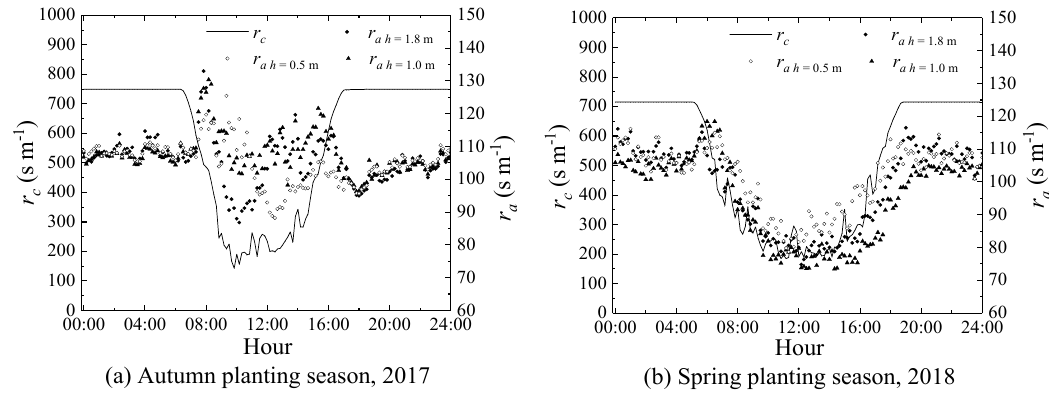
Figure 5. Correlations of the stomatal resistance ( r s ) with solar radiation ( R s ) from 07:00 to 18:00 on 17 April, 23 May, and 22 June 2018.